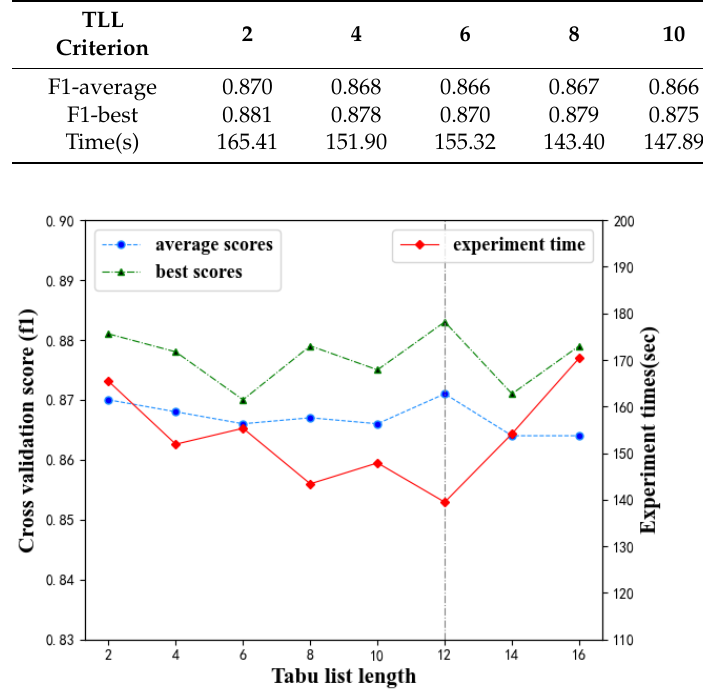
Figure 13. Effect of TLL on prediction model performance.